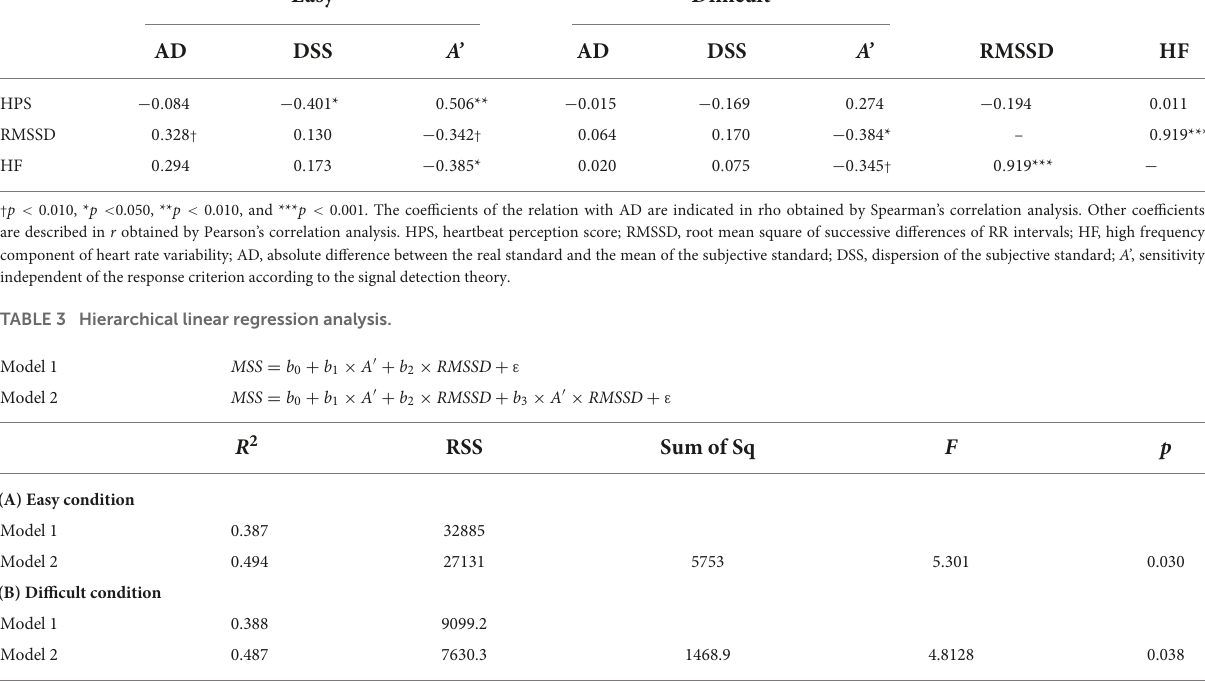
TABLE 2 Correlations between interoceptive accuracy, vagal activity, and indices of temporal task performance. Easy Difficult